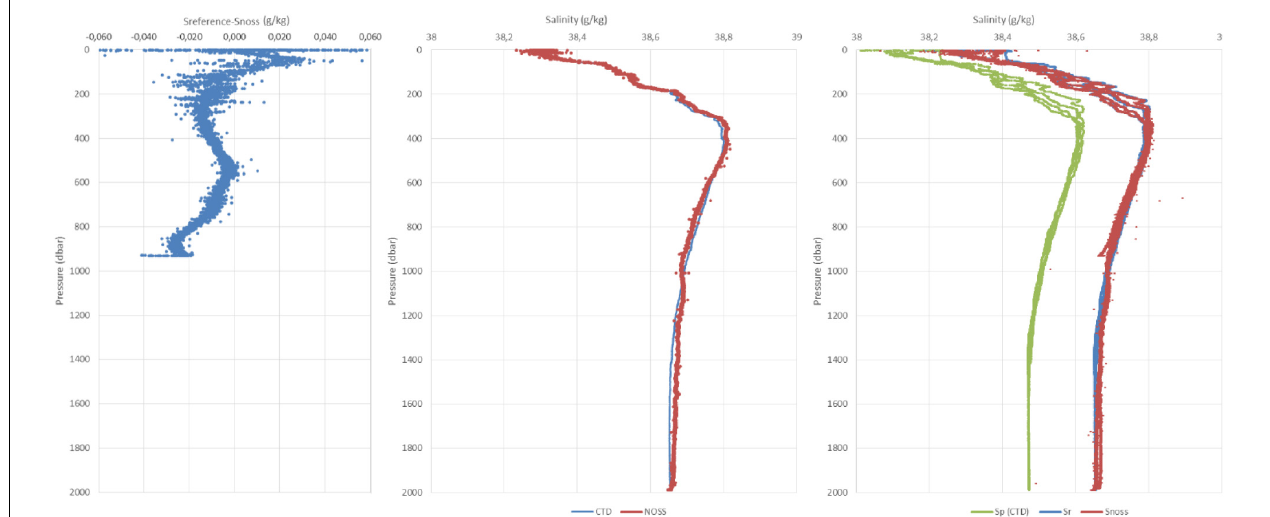
FIGURE 9 | Left : The deviations obtained with the NOSS n ◦ 2 between a reference Absolute Salinity calculated from the TEOS-10 and the salinity obtained with the calibrated NOSS during the first profile. Center : The response obtained during a profile at 2,000 m. Deviations at 400 m could be explained by response-time problems. Right : NOSS data post-processed after the oceanographic campaign carried out in the Mediterranean Sea in 2015, and in comparison with reference salinity (Sp, green; S noss , red; and TEOS-10, blue).